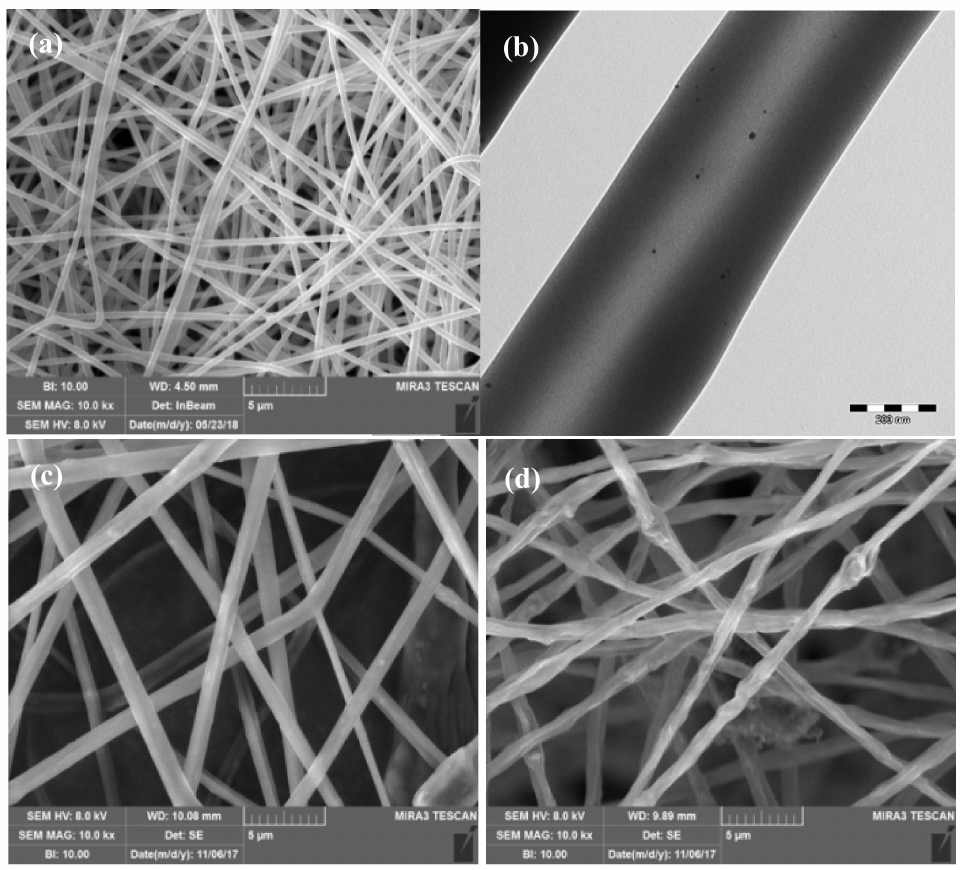
Figure 2. Images of nanofibrous sca ff olds as dermal substitutes: ( a ) polymer-based matrix; ( b ) polymer- based matrix embedded with silver nanoparticles; ( c ) polymer-based matrix embedded with halloysite and ( d ) with montmorillonite adapted from [53–55]. CC BY